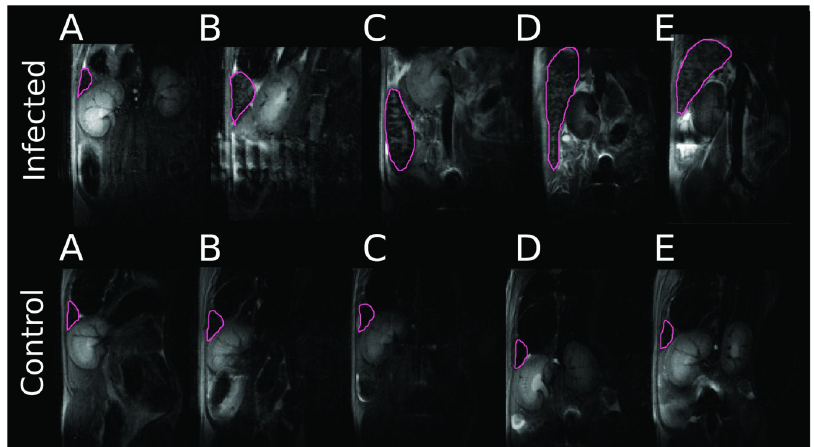
Fig 2. MR images of two mice. T 2 weighted images of one infected and one uninfected (control) mouse throughout the experiment. Animals were scanned at days 0 (A), 7 (B), 14 (C), 21 (D) and 28 (E) post-infection or similar timepoints in control (uninfected). Increased spleen size can be seen in the infected animal at all timepoints post- infection (p < 0.005). No splenomegaly was apparent in the control mouse. The spleen is outlined in pink.